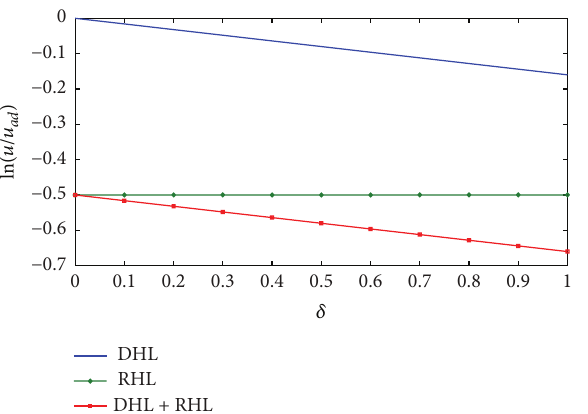
Figure 4: Relative importance of sources of heat loss in determining the flame velocity of laminar spray flames as function of the initial liquid fuel load, evaporation front case. DHL = droplet heat loss only, RHL = radiative/volumetric heat loss only, and DHL + RHL = combined droplet and radiative/volumetric heat loss.